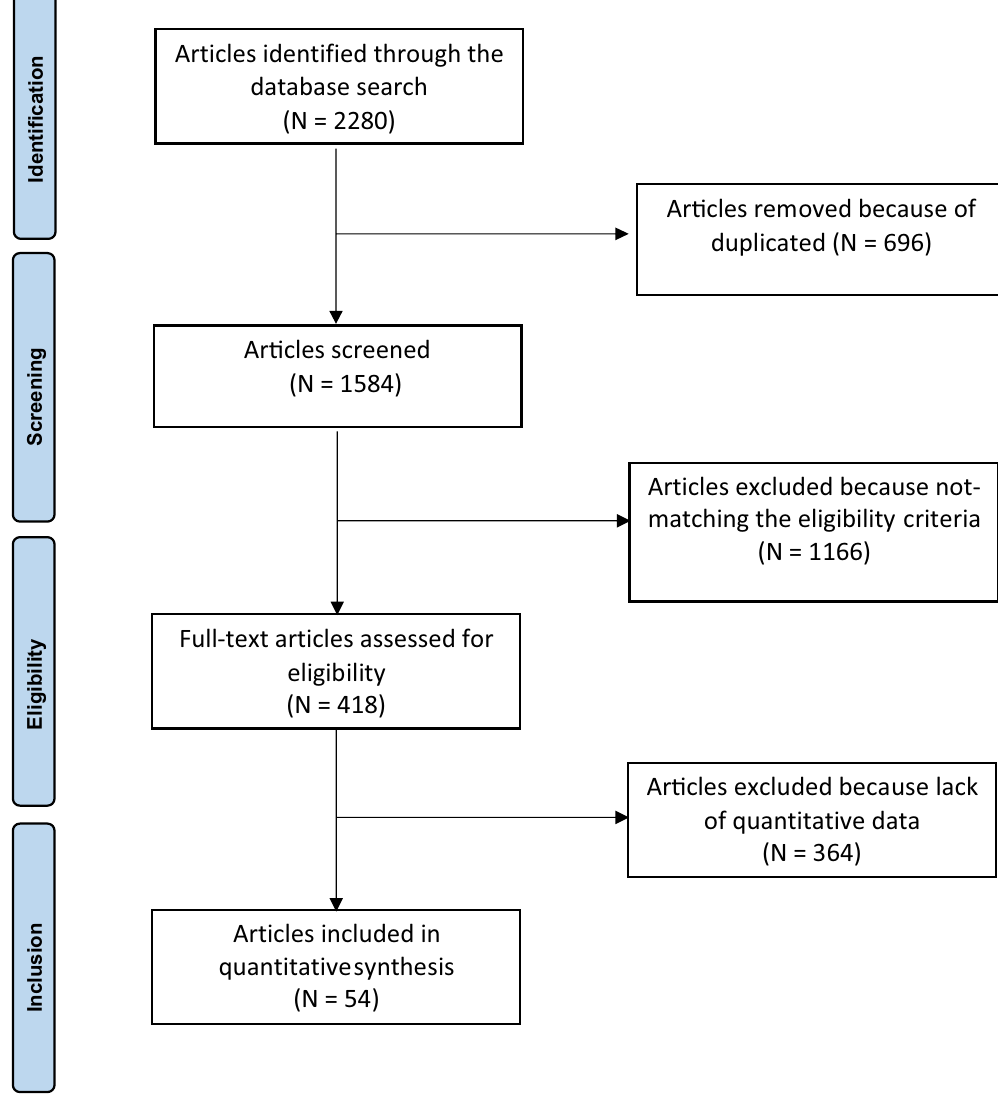
Figure 1. Flow-chart of literature